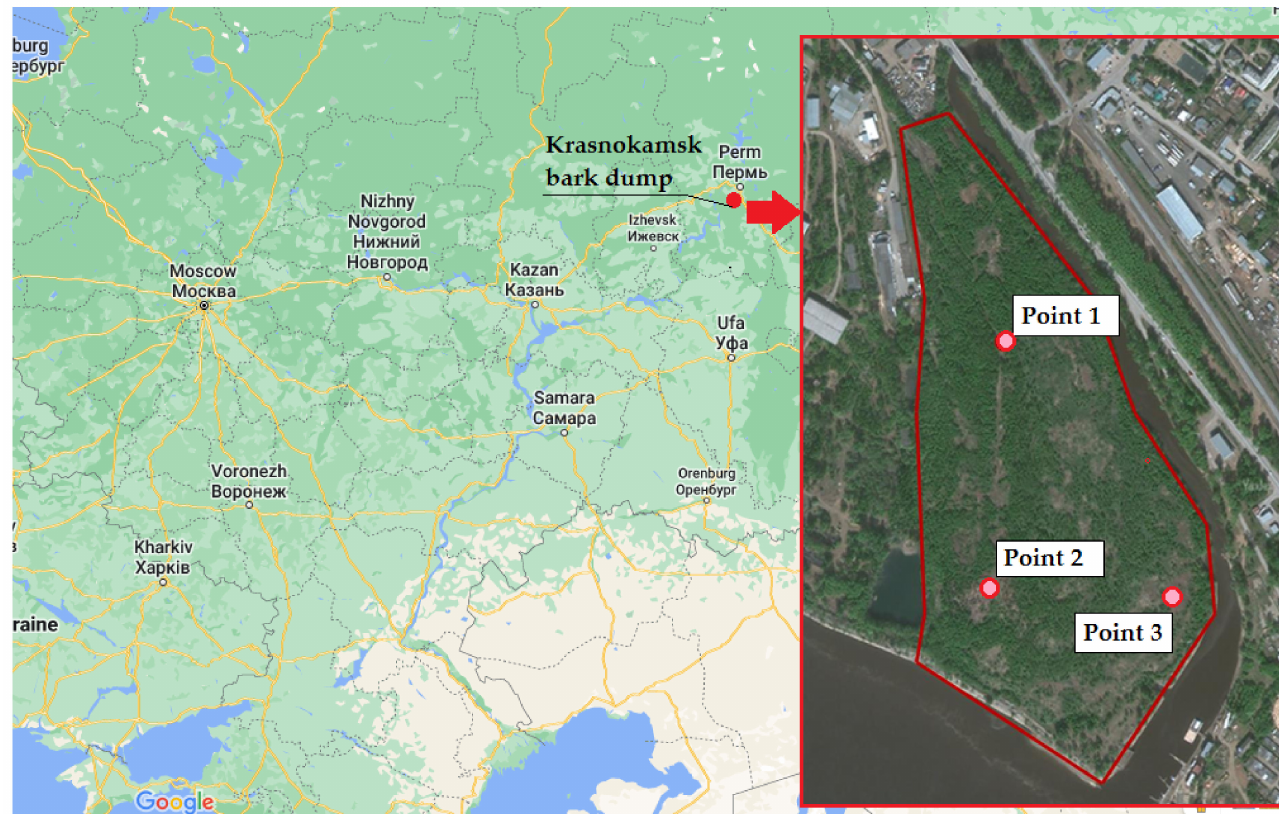
Figure 1. Location of the studied bark dump and sampling site (primary cartographic basis from the website https://www.google.com/maps/, accessed on 18 March 2022).